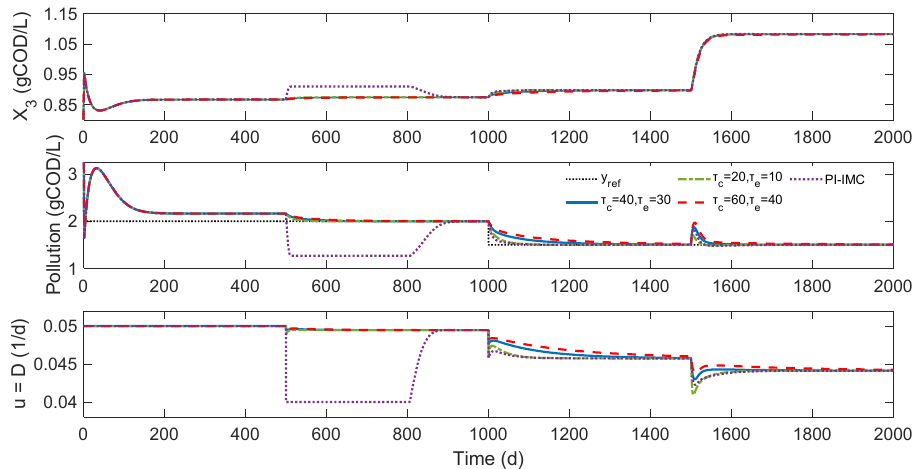
Figure 3. Closed-loop performance of the MEC controller for the organic pollution control problem.